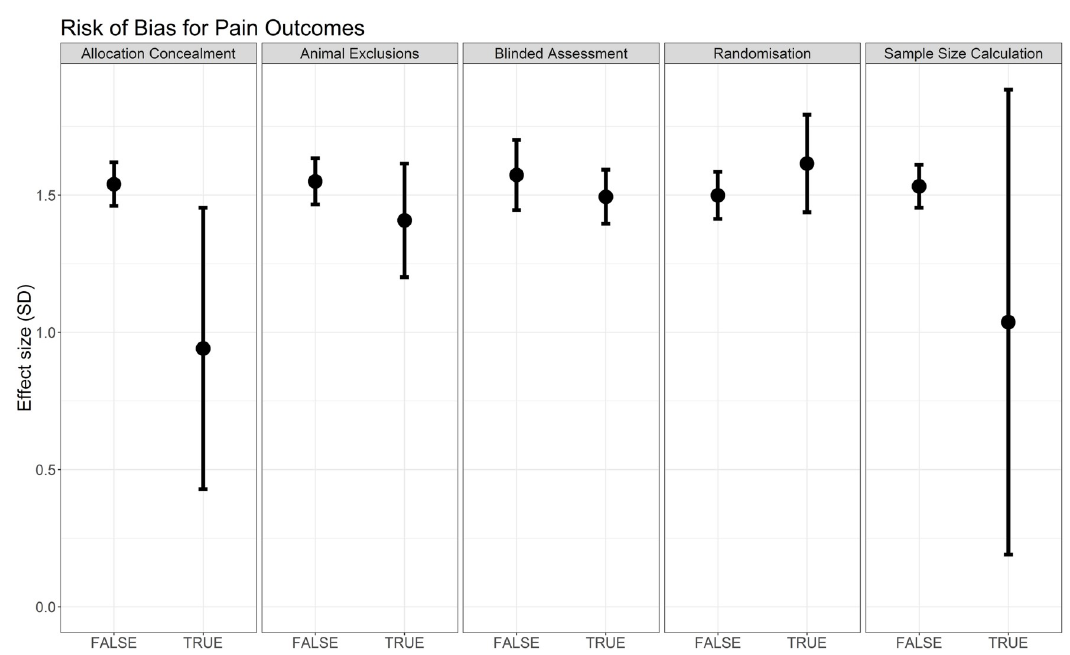
Fig 13. Effect sizes associated with measures to reduce risk of bias in intervention experiments using pain-related behavioural outcomes (data set 2a).